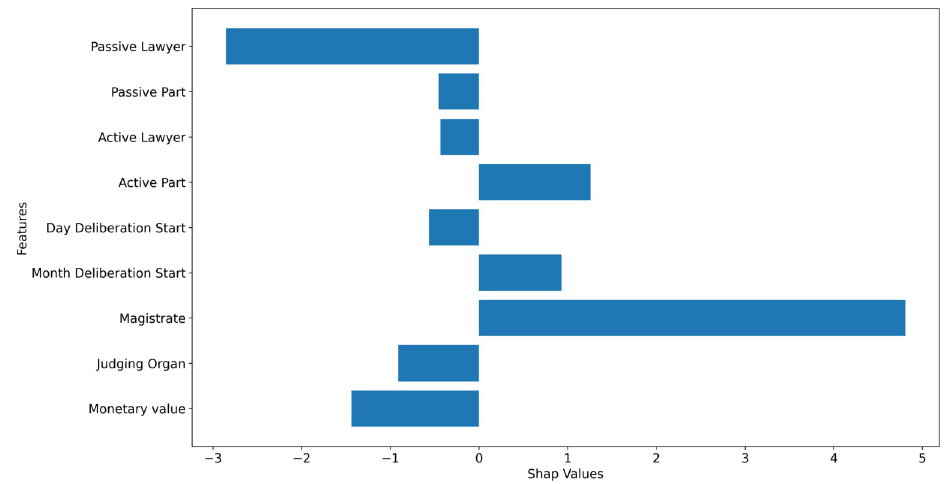
Fig 3. The contribution of each feature for the increase or decrease of the prediction